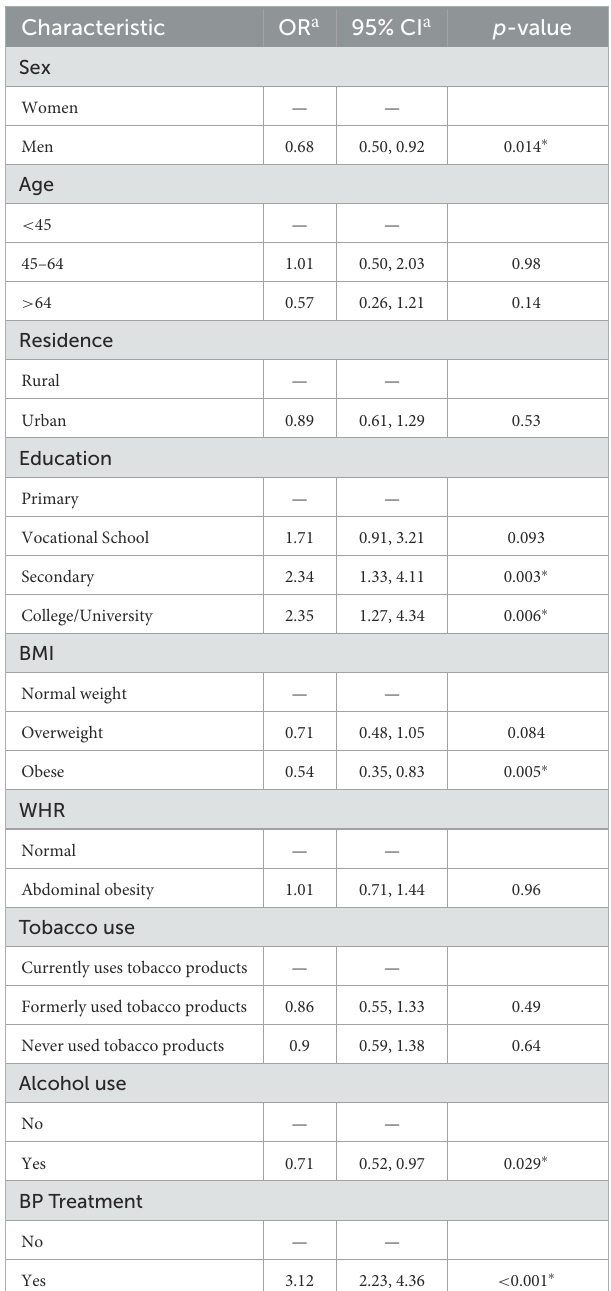
TABLE 2 Analysis of chance for controlled hypertension after 9 years with corresponding